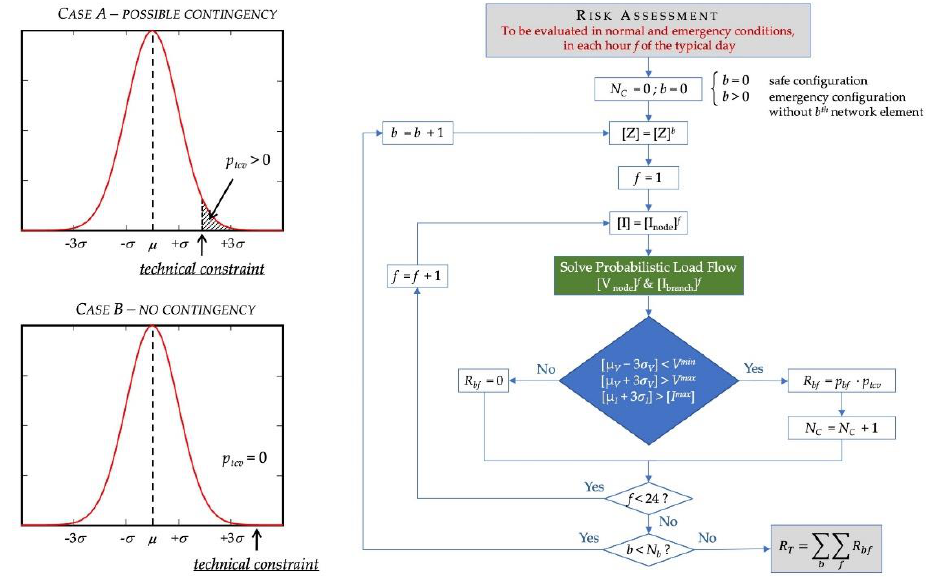
Figure 3. Identification of potential contingencies ( p tcv > 0) and flow chart of total risk assessment.